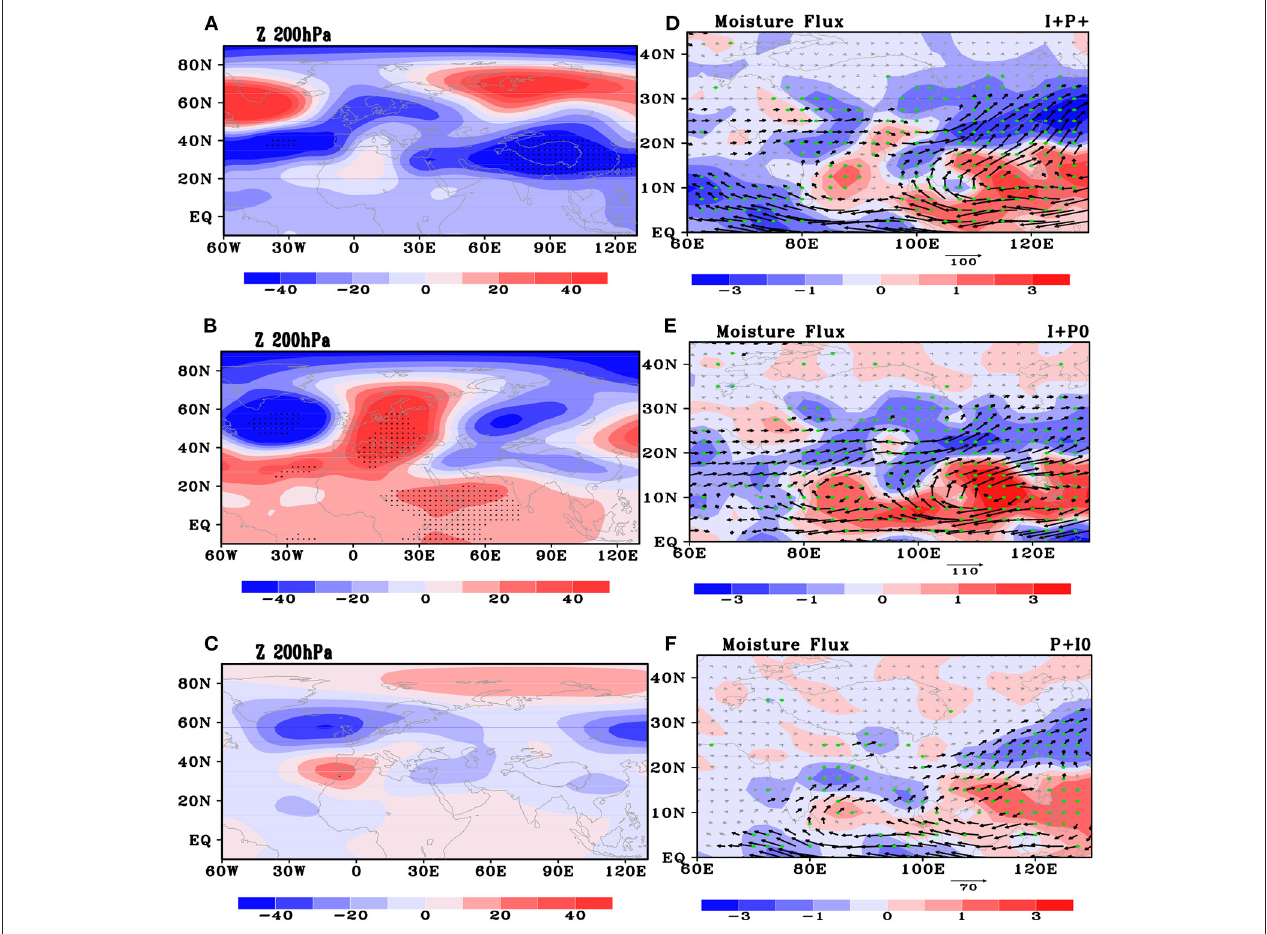
FIGURE 5 | The early winter circulation at positive IOD and ENSO combinations (A–C) . For 200 hPa geopotential height (gpm), (D–F) . For moisture flux (kg m − 1 s − 1 ). (A,D) refer to the positive IOD and El Niño combination case, (B,E) refer to the case of positive IOD and neutral ENSO, (C,F) refer to the case of positive El Niño and neutral